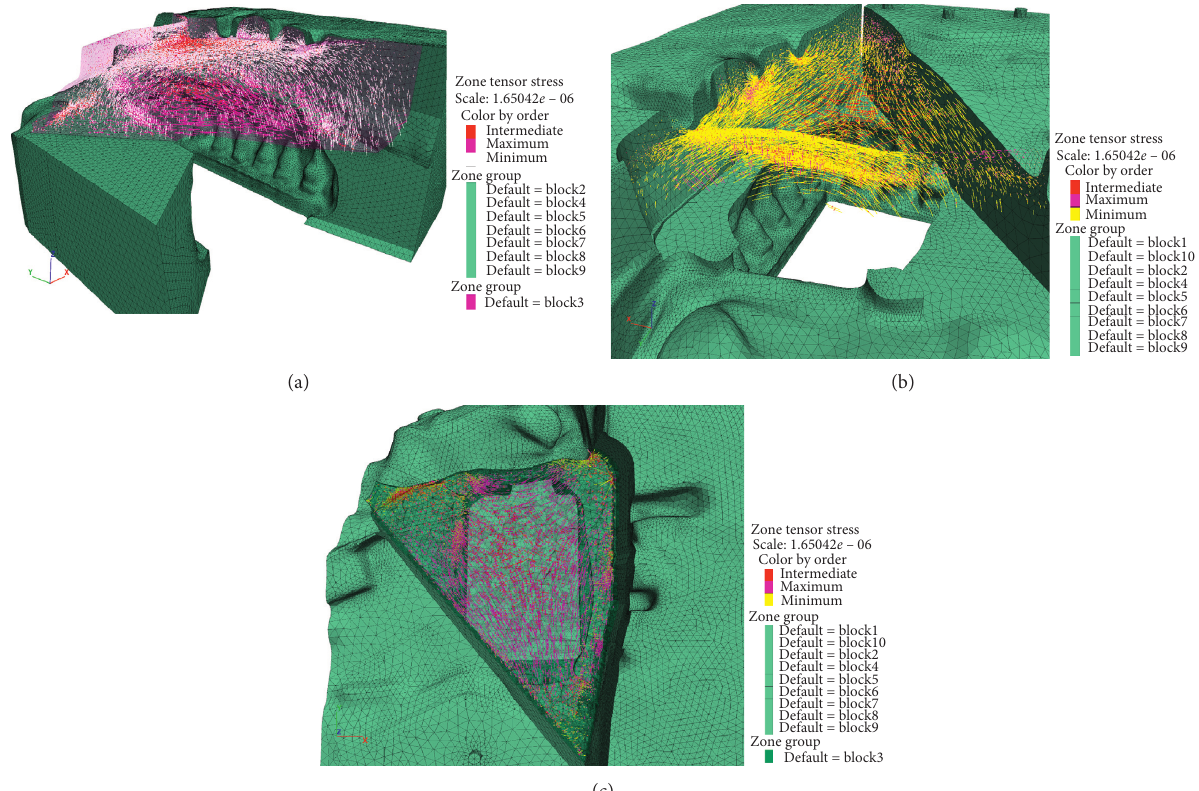
Figure 14: Stress trace diagram of the local model of Yuanjue Cave. (a) Overall stress trace of the roof, (b) stress trace in the top half of roof, and (c) stress trace in the lower half of the